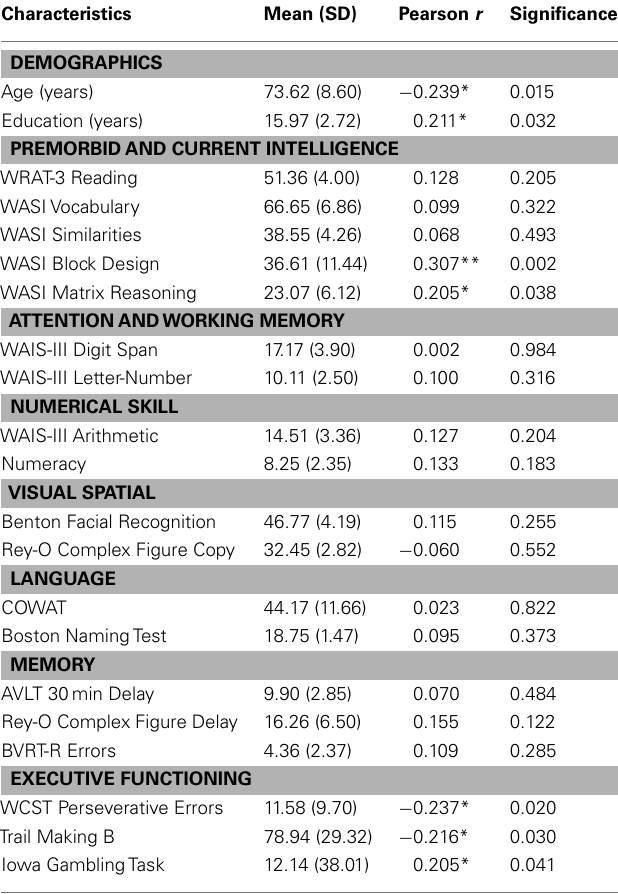
Table 3 |Association of FDMQ Depth of Reasoning with Neuropsychological